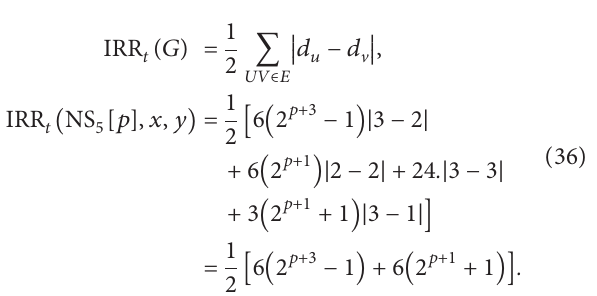
Figure 7: Curves of irregularity index σ .